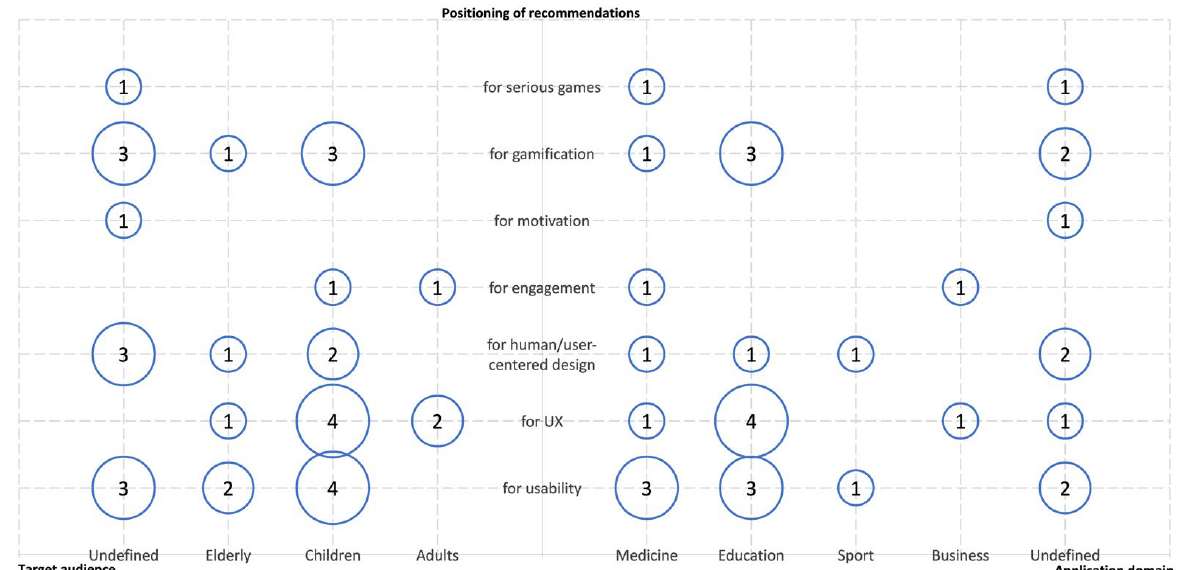
Figure 4. Number of publications in relation to declared gamification target audience, gamification application domain and positioning of recommendations.